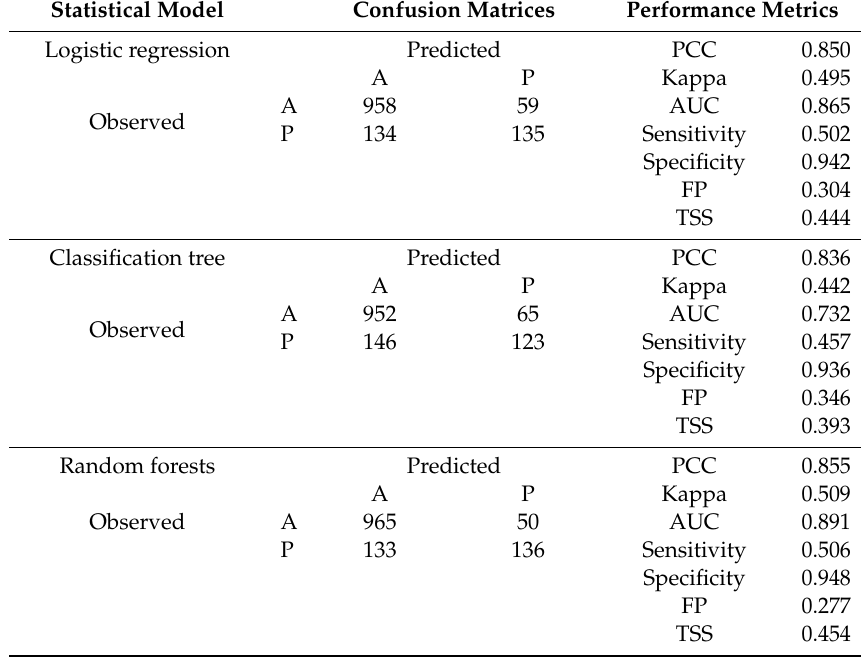
Figure 4. Histogram of stand age distribution for all plots, only plots with western larch seedlings present, and only plots with recent fire disturbance. Table 2. Confusion matrices and performance metrics for each statistical model of seedling presence. A = absence; P = presence; PCC = percent correctly classified; Kappa = Cohen’s kappa; AUC = area under receiver-operator curve; FP = false presence rate; TSS = true skill statistic.